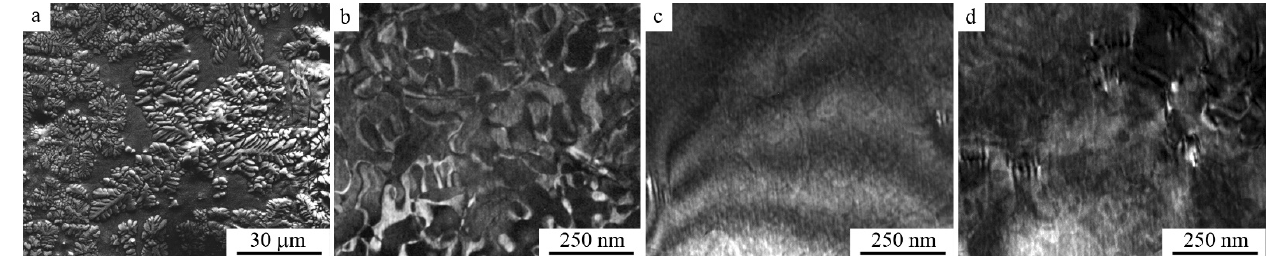
Figure 1. ( a ) Secondary electron SEM image and ( b , d ) bright- and ( c ) dark-field TEM images (amplitude contrast) of the Cu-14Al-4Ni alloy in the ( a ) as-cast and ( b – d ) quenched austenite states.